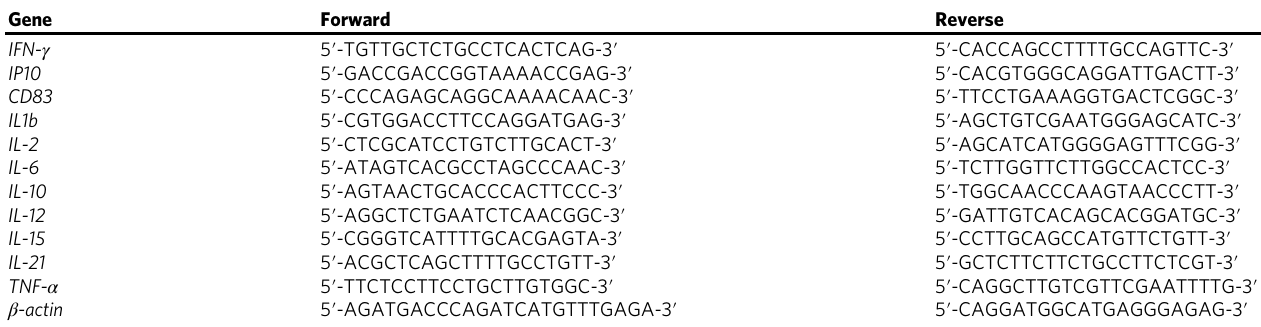
Table 1 qPCR primers designed to amplify mRNA of Syrian hamster immune modulators